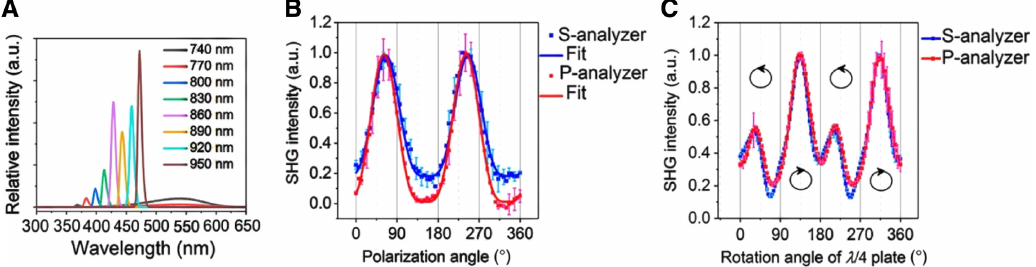
PbBr (DMSO) perovskite. 1.5 3.5 0.5 PbBr (DMSO) nanowire pumped at various wavelengths. (B) SHG intensity from a horizontally 1.5 3.5 0.5 PbBr (DMSO) nanowire as a function of the linear polarization angle as tuned by the λ /2 plate. The dots are 1.5 3.5 0.5